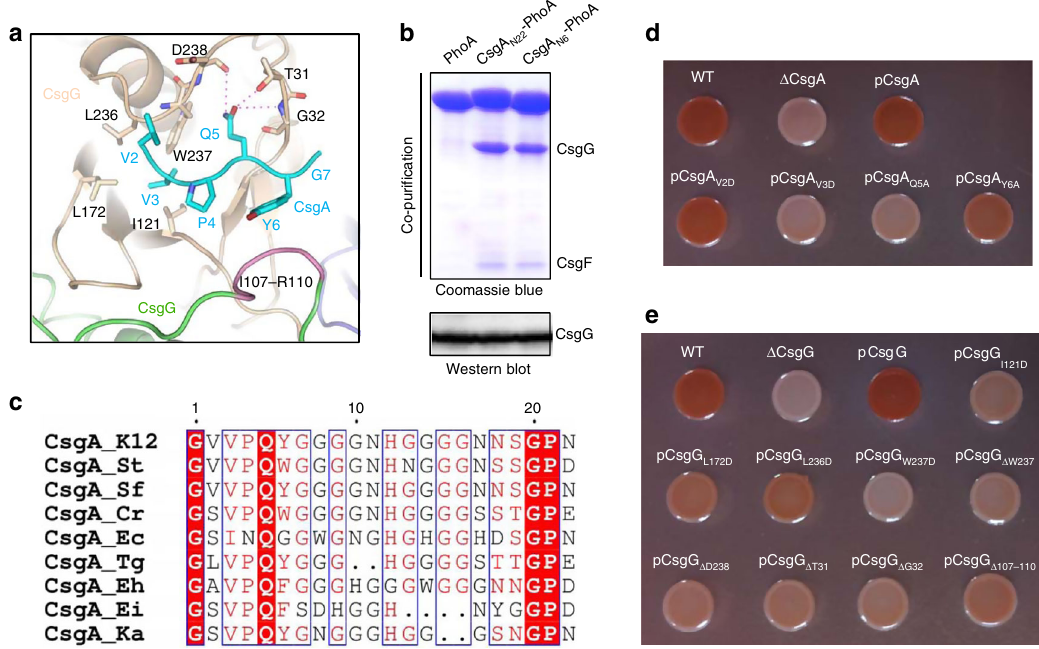
Fig. 5 Analysis of interaction between CsgA N22 and CsgG channel. a Area of interaction between CsgA N22 and the CsgFG channel. Six residues of CsgA N22 are shown in cyan with side chains, while the two adjacent CsgG subunits are shown in wheat and green, respectively. Hydrogen bonds are shown as red dashed lines. b Co-puri fi cation assay of CsgA N6 and CsgA N22 with CsgG as detected by Coomassie blue staining. Detergent-solubilized CsgG supernatant was detected by western blotting. Source data are provided as a Source Data fi le. c Multiple sequence alignment of CsgA N22 from several species. K12, Escherichia coli K12 strain; St, Salmonella typhimurium LT2 strain; Sf, Shigella fl exneri ; Cr, Citrobacter rodentium ICC168 strain; Ec, Enterobacter cloacae EcWSU1 strain; Tg, Trabulsiella guamensis ATCC 49490 strain; Eh, Enterobacter hormaechei ATCC 49162 strain; Ei, Enterobacter intermedius ; and Ka, Kosakonia sacchari SP1 strain. d Congo red secretion assay for the single mutations in CsgA N6 . Source data are provided as a Source Data fi le. e Congo red secretion assay for the single mutations or deletions of CsgG corresponding to interactions with CsgA N22 . Source data are provided as a Source Data fi